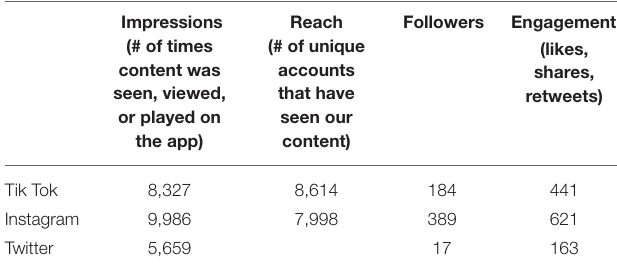
TABLE 3 | Social media platform performance.